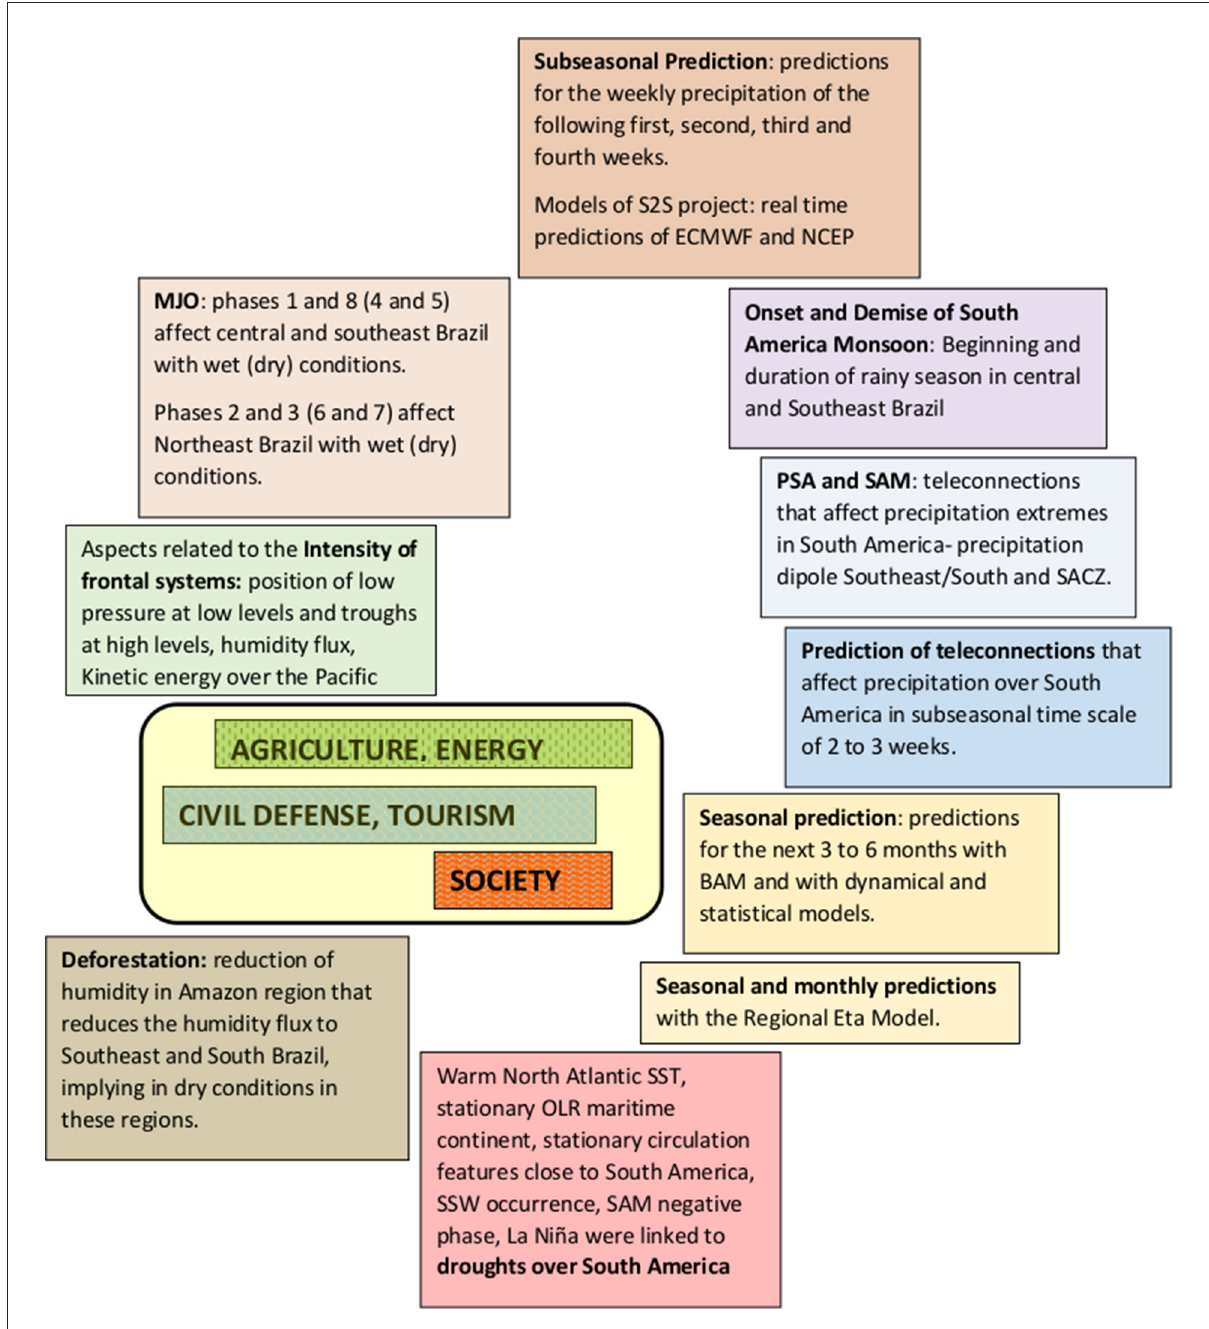
FIGURE1 Features that could be monitored and predicted as a contribution to actions of Climate Services applied to Agriculture, Energy, Tourism, Civil Defense and